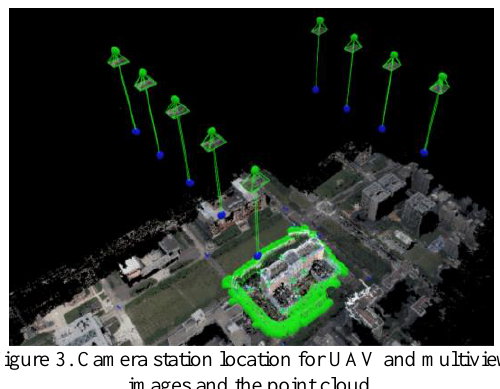
Figure 3. Camera station location for UAV and multiview images and the point cloud.